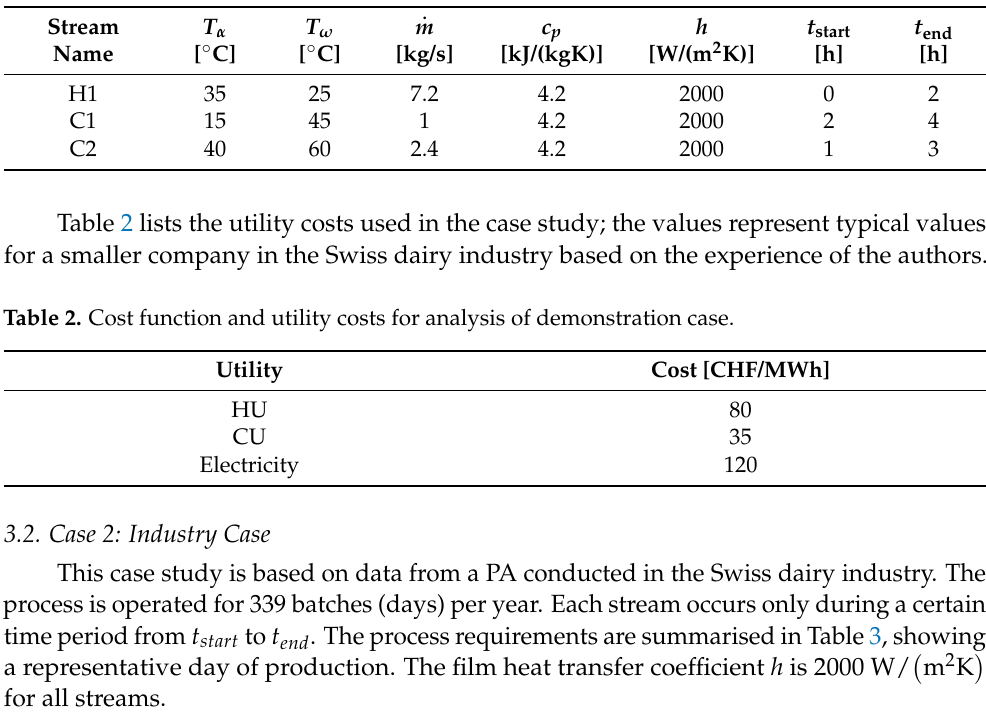
Table 1. Process stream table of Case 1.